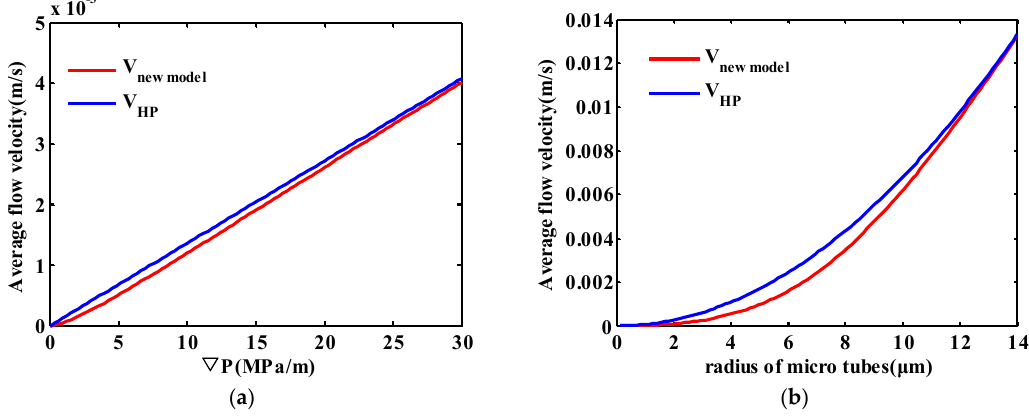
Table 2. Parameters used to study fluid-solid interaction on average flow velocity.